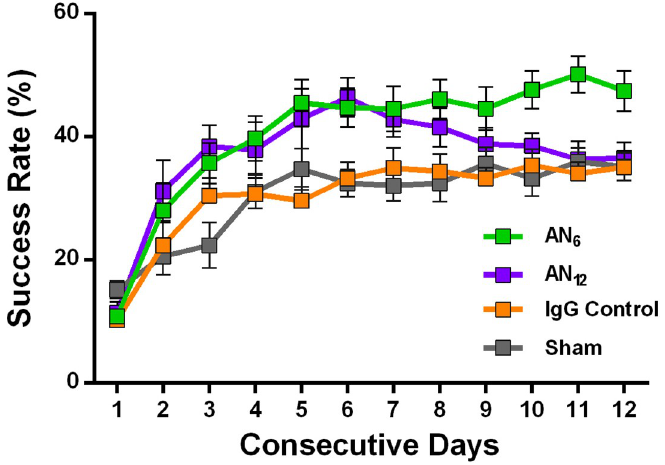
Fig 2. Temporal influence of anti-Nogo-A antibody treatment on in vivo motor learning. (a) Experimental timeline. (b) Rats were exposed to a precision forelimb reaching task while receiving anti-Nogo-A antibodies for the first 6 days (AN 6 : ; n = 8) of motor learning, or for the entire learning period of 12 days (AN 12 : ; n = 7). Control groups received mouse IgG control antibodies (IgG controls; ; n = 6), or no antibody treatment (Sham: ; n = 8). Both groups treated with the anti-Nogo-A antibody show significantly higher success rates during the first six days compared to control animals (AN 6 vs. IgG Control: ��� : P = 0.02; AN 12 vs. IgG Control: ��� : P = 0.01). Note, that in animals, in which treatment with anti-Nogo-A antibodies was terminated after 6 days, a superior success rate was maintained until the end of the consecutive 12-day training period (AN 6 vs. An12, IgG Control and Sham: ��� : P = 0.0002), while animals receiving anti-Nogo-A antibodies over consecutive 12 days show a decline in the number of successfully grasped pellets during the second week (day 12: AN 6 vs. AN 12 : ��� : P =